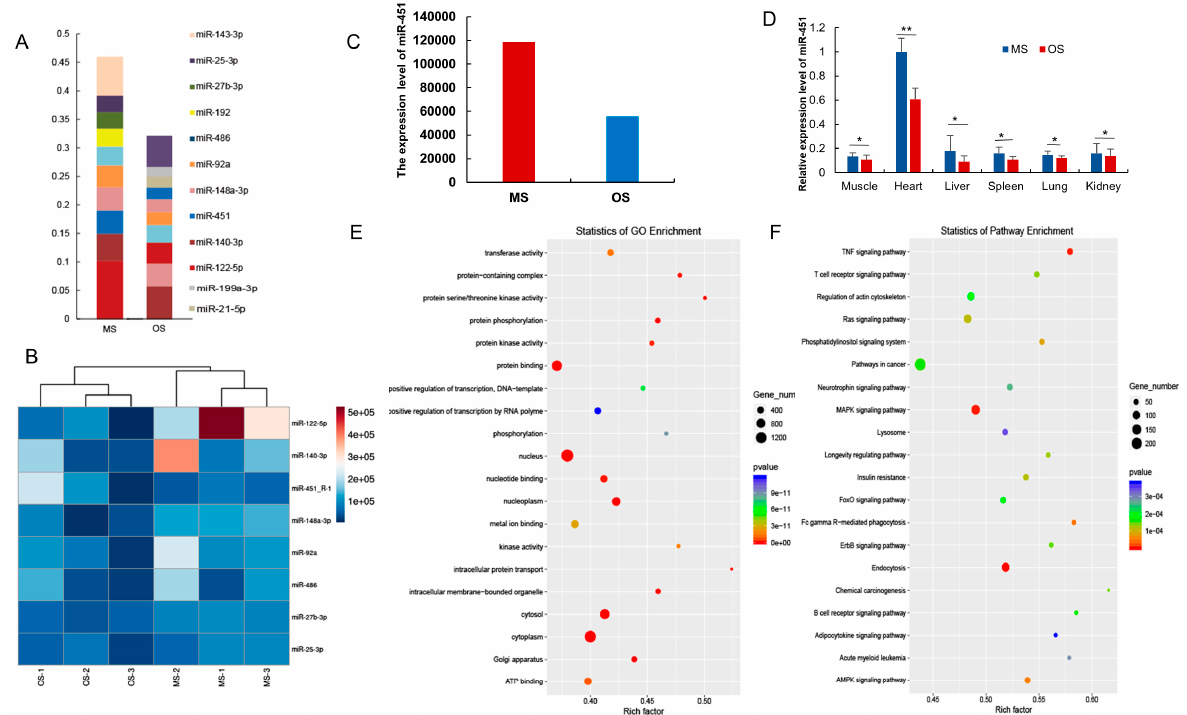
Figure 4. Analysis of pig cord blood enriched miRNAs of OS and MS. ( A ) Analysis of miRNAs generally abundant across Exo-OS and Exo-MS; ( B ) Clustering of differentially expressed miRNAs of Exo-OS and Exo-MS; ( C ) The expression level of miR-451; ( D ) Relative expression level of miR-451 in different tissues; ( E ) GO enrichment of high expressed miRNAs; ( F ) KEGG enrichment of high expressed miRNAs. * or ** represents significance at the 0.05 or 0.01 level,